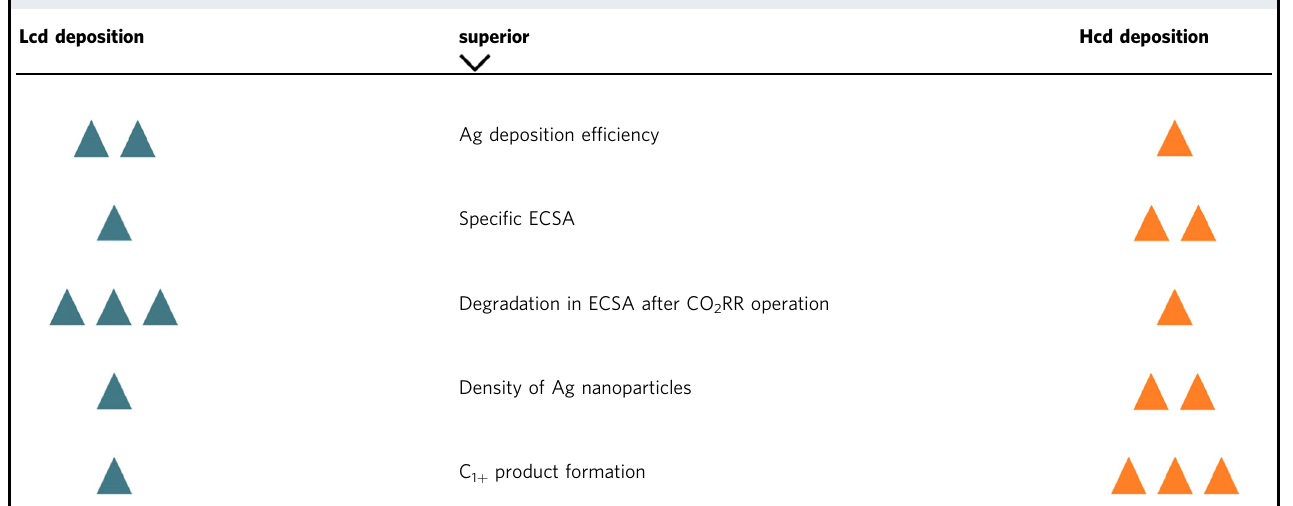
Table 3 Summary of structure relationship parameters between the Dynamic Hydrogen Bubble Templation process and CO 2 RR